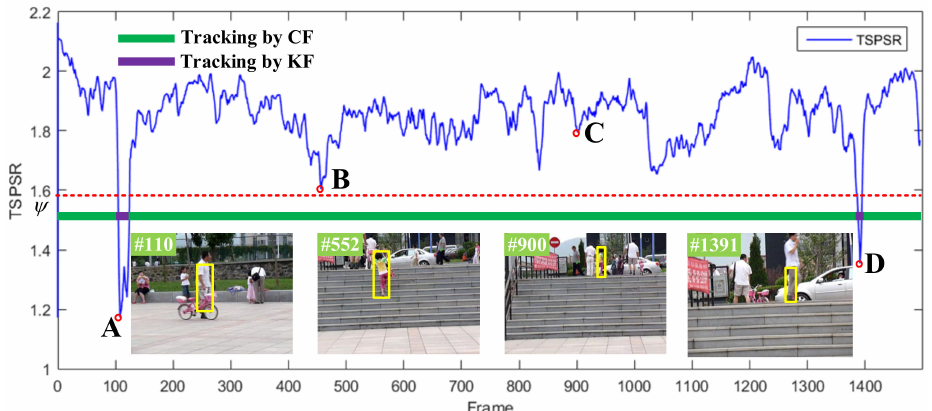
Figure 4. Distributions and analysis of time-space peak to sidelobe ratio (TSPSR) value on the Girl2 sequence. The green line represents the stage of tracking by CF, and the purple line represents the stage of tracking by KF. The four points A to D correspond to different frames, and the tracking model is selected according to the value of